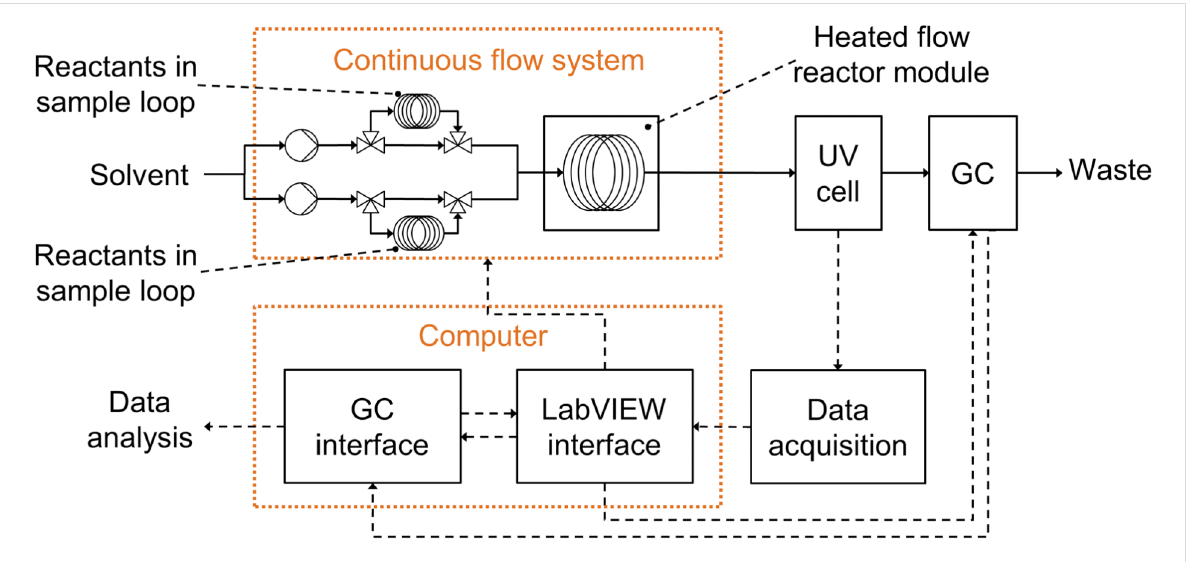
Figure 2: Schematics of the automated continuous-flow system used for model development and ‘black-box’ sequential optimisation.